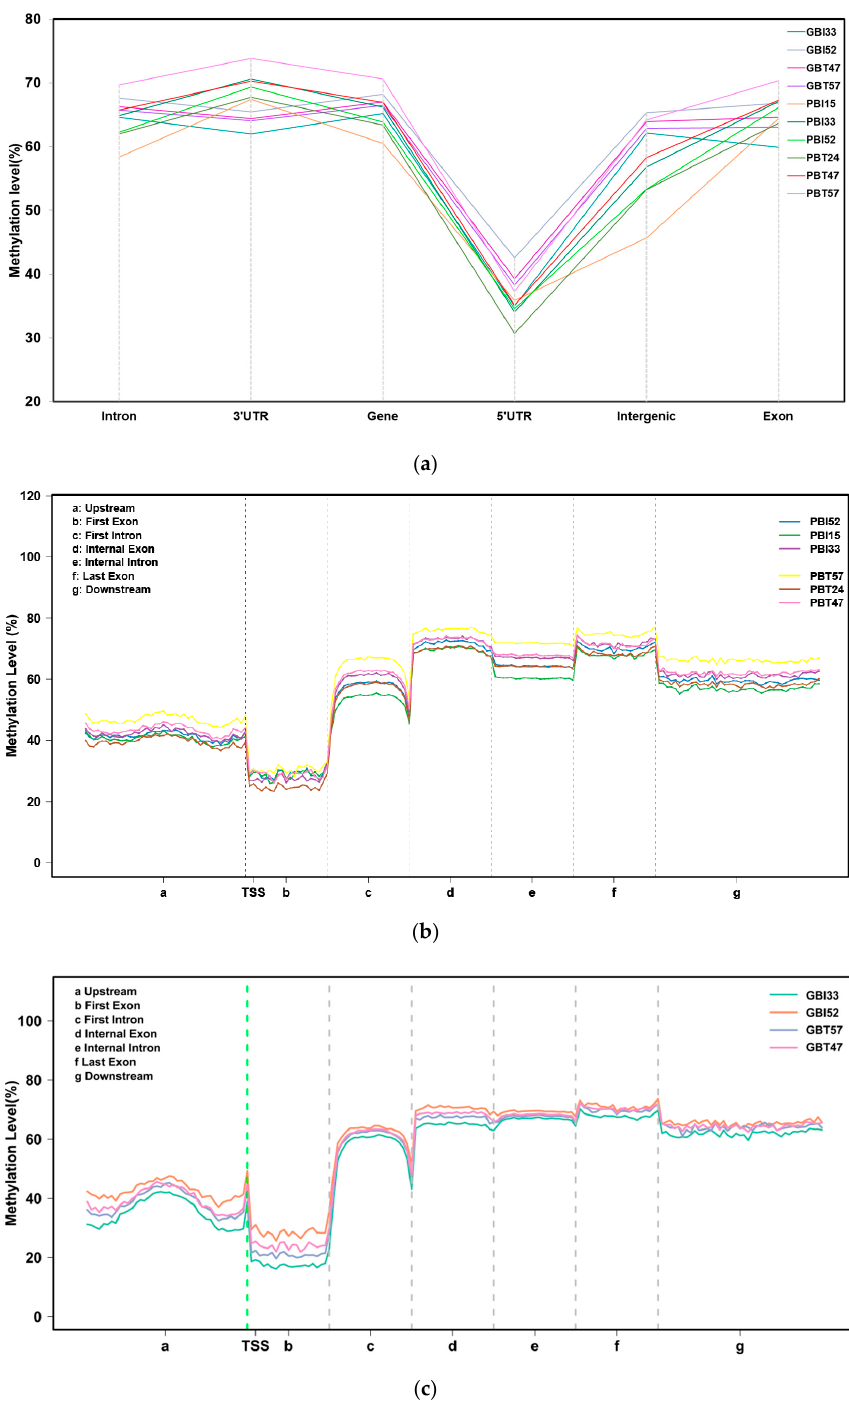
Figure 2. Methylation levels in different functional areas. ( a ) DNA methylation levels of 10 samples in different functional regions of the genome under a CG background. The x-axis indicates the names of the functional regions. The y-axis indicates the methylation level (%). ( b ) Distribution of DNA methylation levels on different transcription elements in the CpG background of the spleen group. The x-axis indicates the different regions of gene transcription elements; the y-axis indicates the methylation level. ( c ) Distribution of DNA methylation levels on different transcription elements in the CpG background of the liver